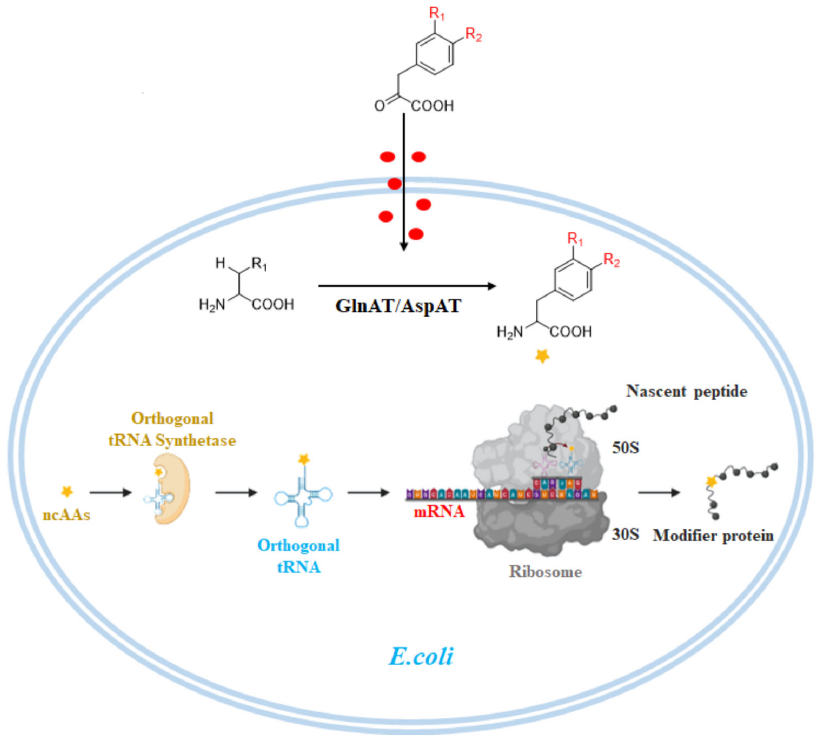
Figure 1. Simple intracellular metabolic conversion (biotransformation) of phenylalanine derivatives by their α -keto acid precursors. Incorporation of ncAAs from phenylpyruvate derivatives into pro- teins is enabled by the orthogonal aminoacyl-tRNA synthetase, which aminoacylates an orthogonal tRNA with the ncAA. The aminoacylated orthogonal tRNA recognizes the amber codon in the mRNA of a protein and introduces the ncAA at this